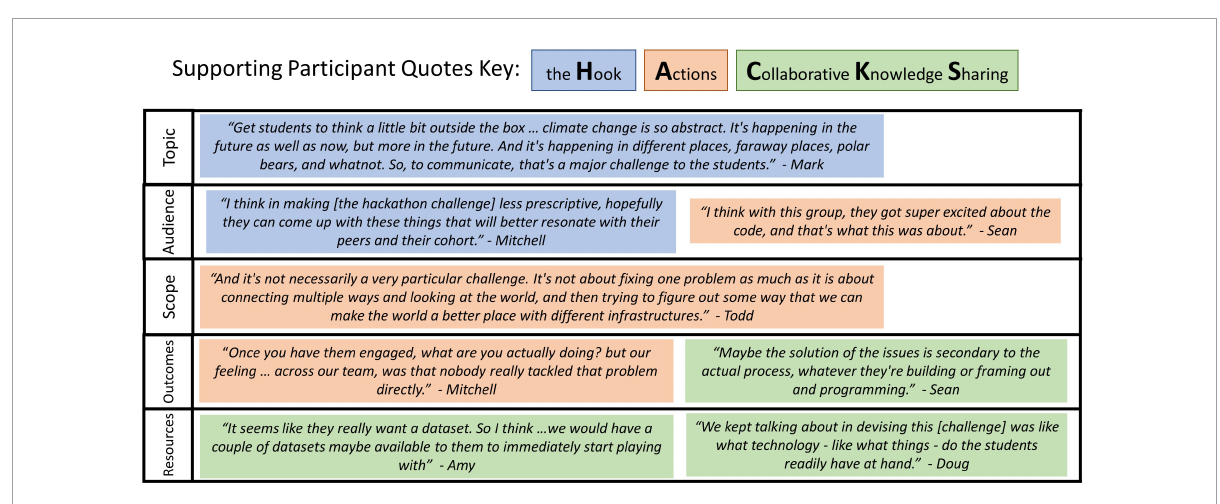
FIGURE3 Cohort participant quotes describing how they evaluated the success and quality of their hackathon